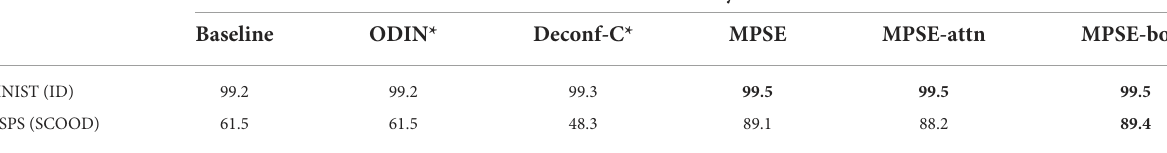
TABLE 3 Classification accuracy of the model after training using the ID dataset (MNIST) on ID and SCOOD data, with the best results shown in bold.